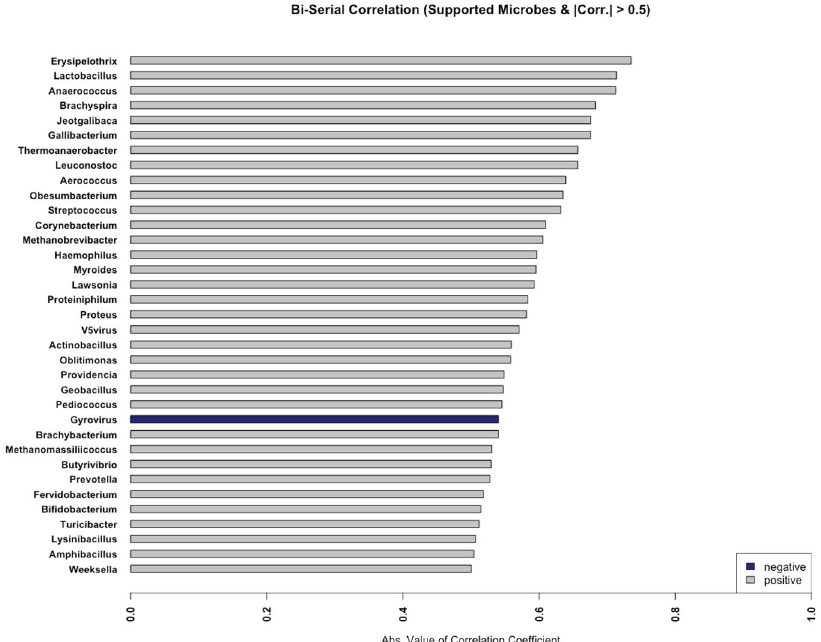
Fig. 8 Salmonella status correlations with genus relative abundances. Only those genera with the absolute value of the correlation coef fi cient >0.5 are shown. Positive and negative correlations are indicated in gray and blue,